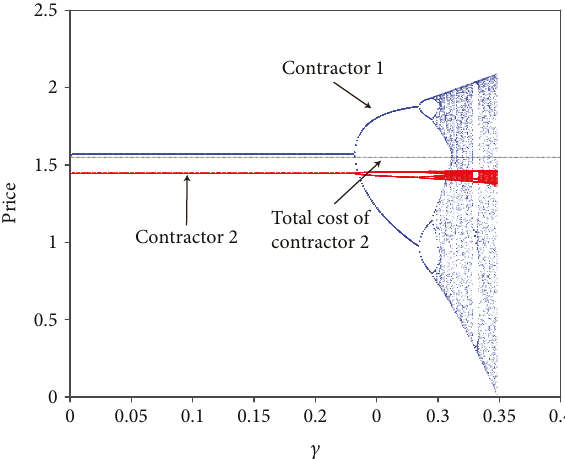
Figure 1: Price bifurcation diagram in situation